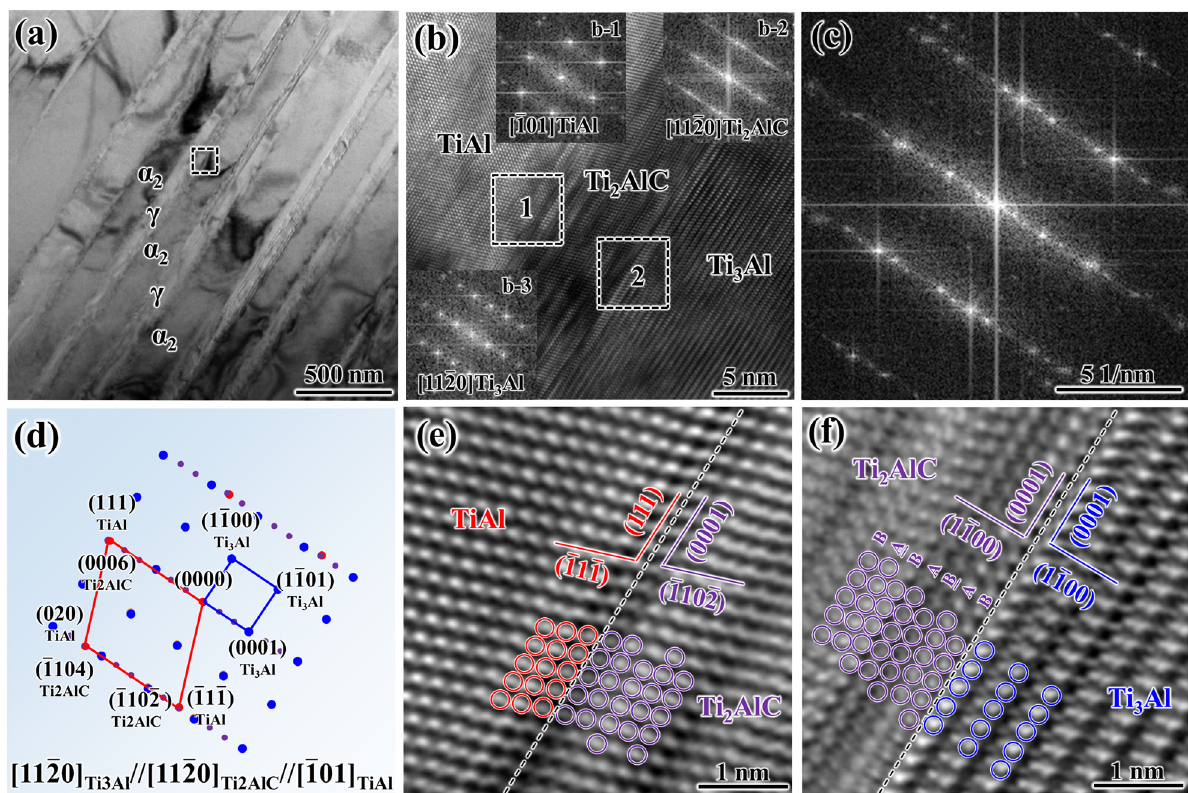
Figure 3: The TEM analysis of rod - like Ti 2 AlC nano - precipitates at the TiAl/Ti 3 Al interface: ( a ) TEM image of TiAl/Ti 3 Al and rod - like Ti 2 AlC; ( b ) HRTEM image of the TiAl/Ti ( c ) FFT pattern of the TiAl/Ti ( d ) indexing of the FFT pattern in ( c ) ; ( e 2 AlC/Ti 3 Al interface; 2 AlC/Ti 3 Al interface;